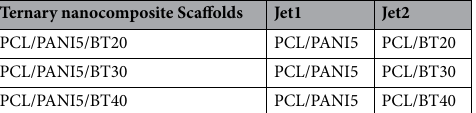
Ternary nanocomposite